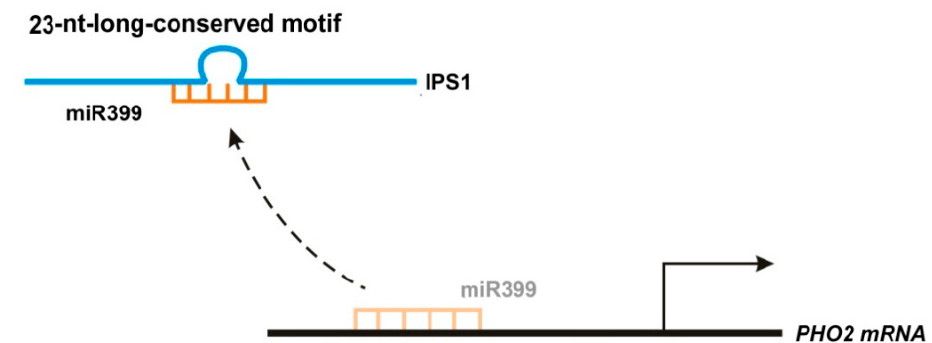
Figure 7. IPS1 functions as an endogenous target mimic through a 23-nucleotide (nt)-long conserved motif. The conserved 23-nt-long motif of IPS1, which shows imperfect complementarity with miR399, ensures binding with miR399. This leads to an increased expression of miR399 target genes and changes in phosphate content, since miR399 can no longer affect its targets.